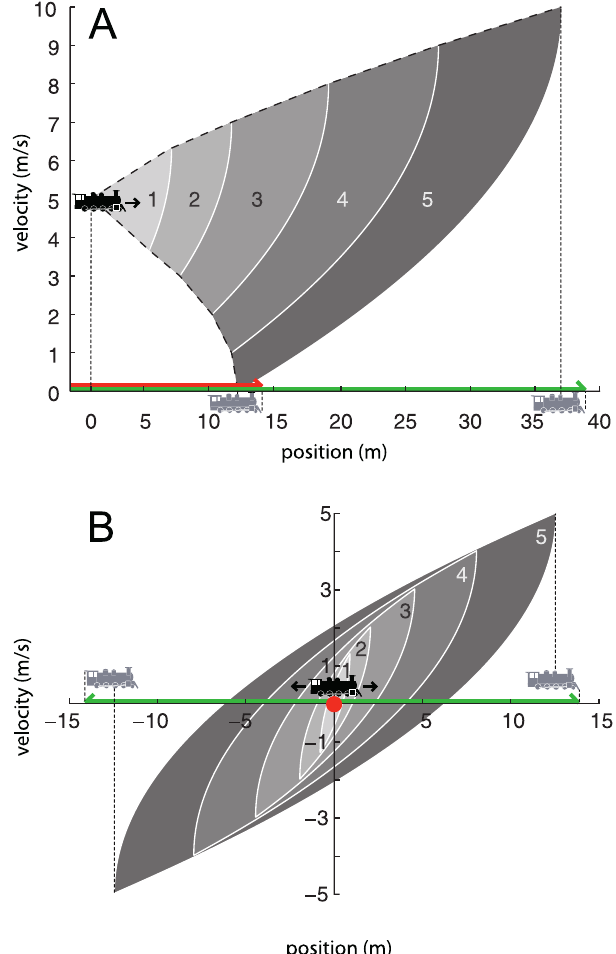
Figure 4. Phase Planes Illustrating the Time-Limited Reachable Set, Time- Limited Motor Volume, and Stopping Motor Volume for a Locomotive Moving on a Train Track from Two Initial Velocities Filled sectors and dashed curves refer to states for the locomotive’s center of mass. The red line/dot indicates the stopping volume for the locomotive; the green line indicates the time-limited motor volume for t (cid:3) 5 s. Both are inclusive of the locomotive surface as indicated by the gray locomotives. (A) x 0 ¼ (0 m, 5 m/s). Upper and lower curved dashed lines represent constant acceleration ( þ 1 m/s 2 ) and deceleration ( (cid:4) 1 m/ s 2 ). Overlapping filled sectors represent reachable sets for time up to and including the labeled times, in seconds. (B) x 0 ¼ (0 m, 0